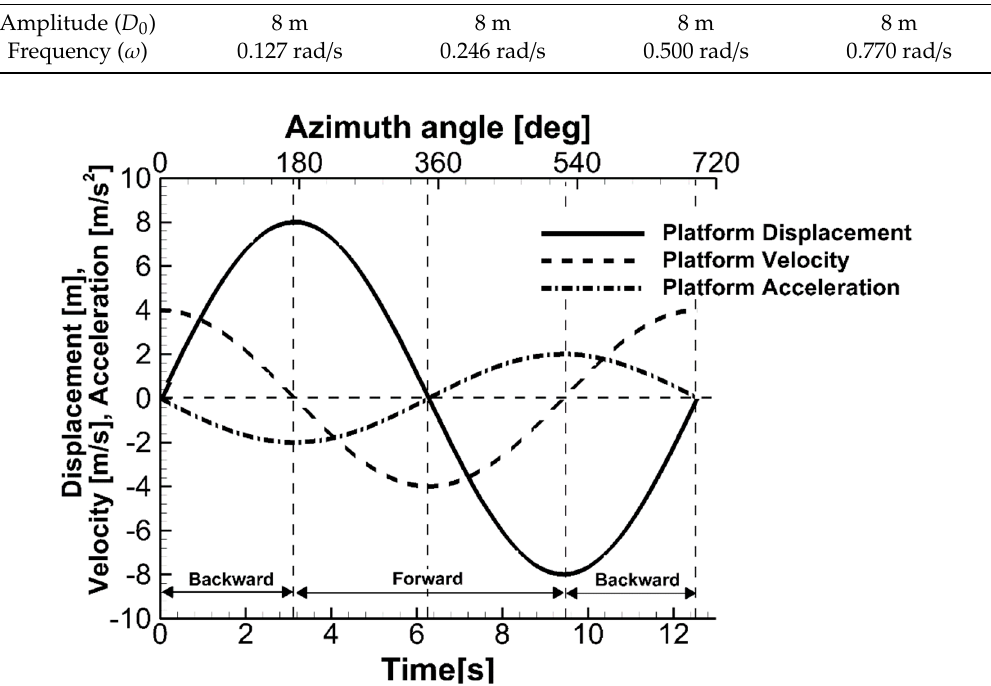
Figure 4. Variations of displacement, velocity, and acceleration of the platform in surge motion ( D 0 = 8 m, ω = 0.500 rad/s).